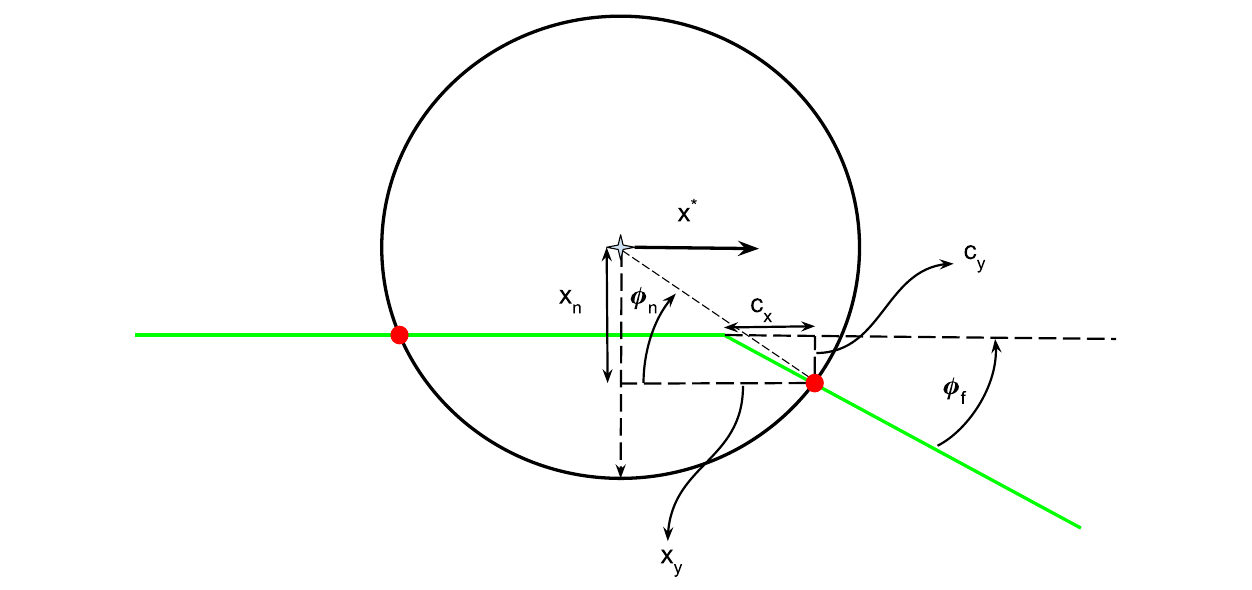
FIGURE 10 | SPR labeled with variables ( c x , c y , ϕ n ) that change with the slide along the mesh surface